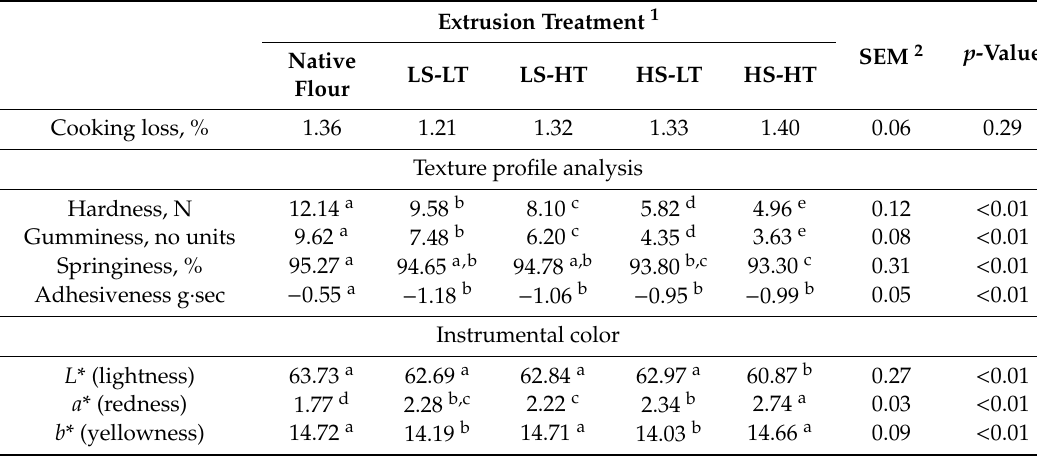
Table 4. E ff ects of the modification of breadfruit flour with extrusion on the cooking loss, texture (storage day 1), and instrumental color of soy protein isolated